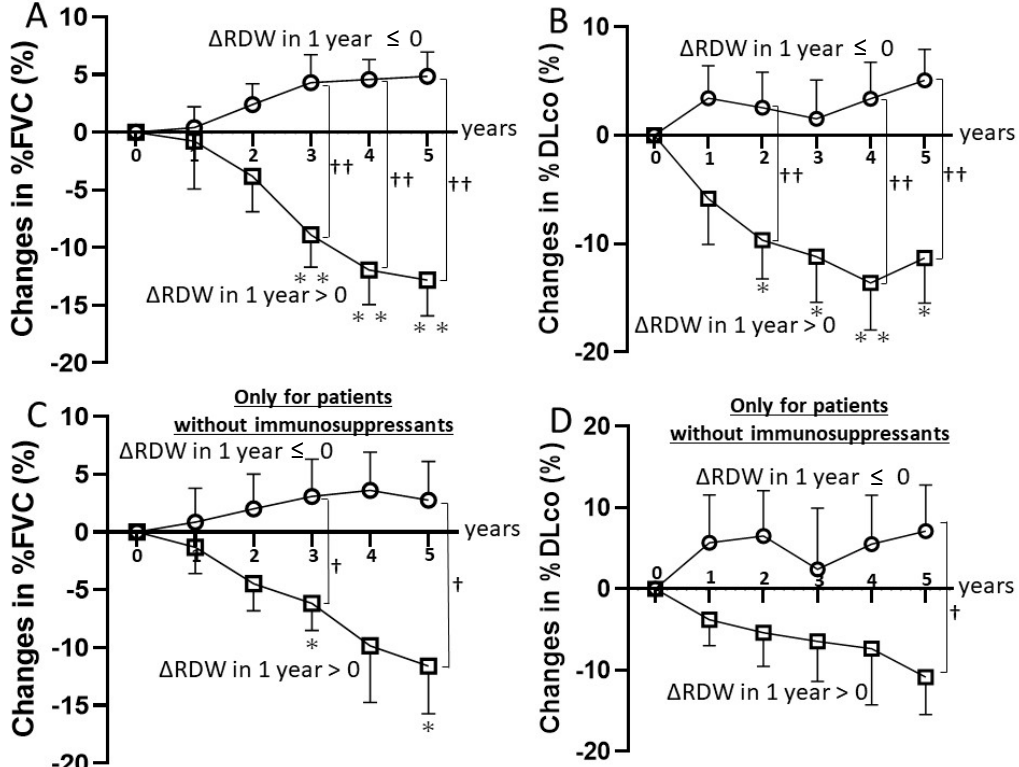
Figure 2. Comparison of SSc-ILD progression stratified by the changes in RDW. ( A ) Changes in %FVC in the group of patients with RDW changes in the first year greater than 0 and in the group of patients with RDW changes in the first year 0 or less. ( B ) Changes in %DLco in the group of patients with RDW changes in the first year greater than 0 and in the group of patients with RDW changes in the first year 0 or less. ( C ) Changes in %FVC in the group of patients with RDW changes in the first year greater than 0 and in the group of patients with RDW changes in the first year 0 or less among patients without immunosuppressants for SSc-ILD in 5 years. ( D ) Changes in %DLco in the group of patients with RDW changes in the first year greater than 0 and in the group of patients with RDW changes in the first year 0 or less among patients without immu-nosuppressants for SSc-ILD in 5 years. The absolute changes between the two groups were compared at 1-, 2-, 3-, 4-, and 5-year assessments. All values represent the mean ± SD. * p < 0.05 and ** p < 0.01 vs. baseline. † p < 0.05 and †† p < 0.01 vs. the group whose changes of RDW in 1 year were greater than